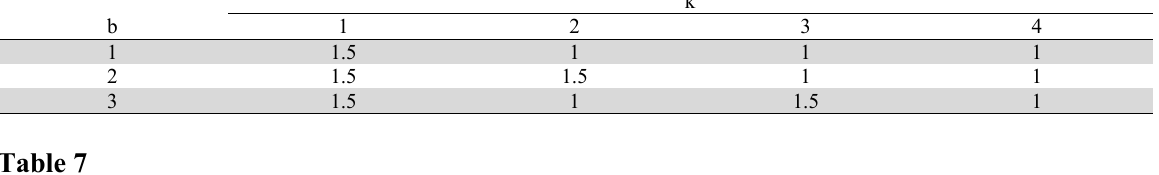
Capacity of Transportation Mode (CT n ) (kg×10 3 )